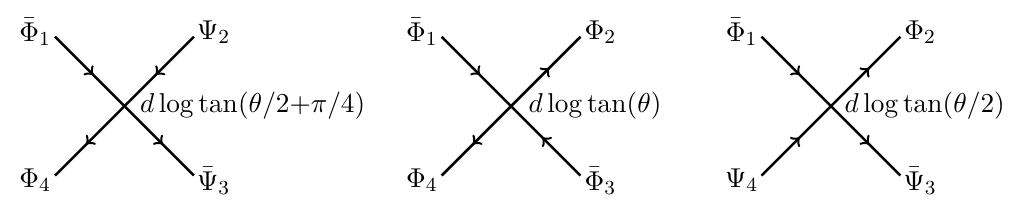
Figure 1. The three four-point vertices of N = 4 formalism of on-shell diagram representation of scattering amplitudes in ABJM